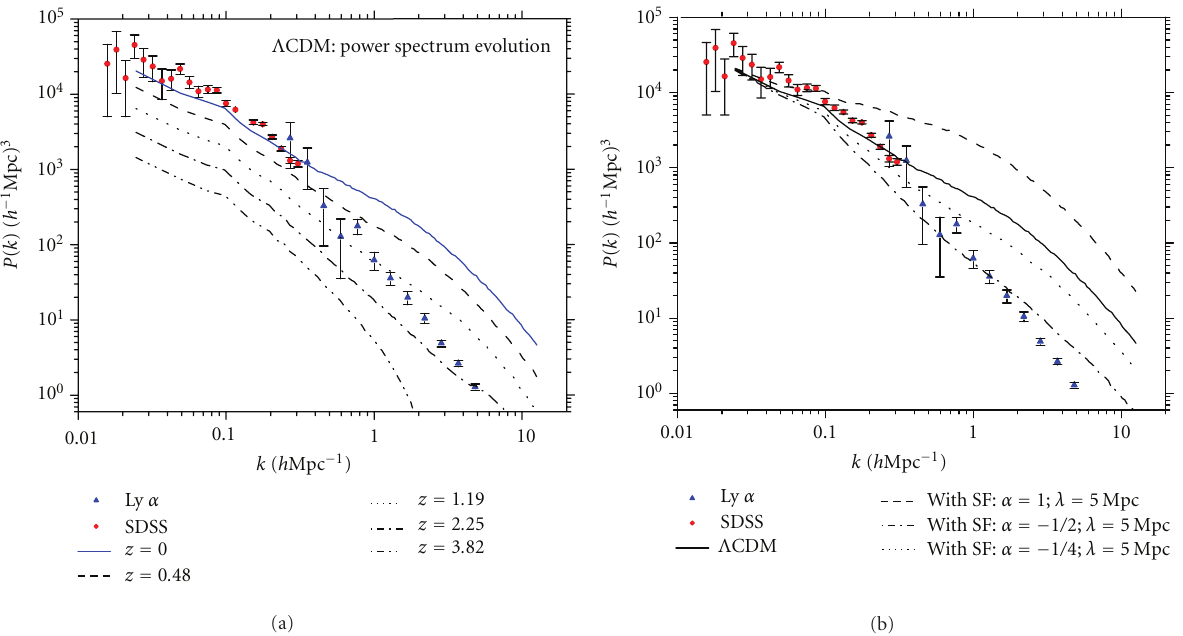
Figure 4: (a) Evolution of the power spectrum for the case which there is no SF. (b) The power spectrum including SF for several values of parameter α and with λ = 5Mp c/h . Experimental data are from galaxies in the Sloan Digital Sky Survey (SDSS) catalog and from an analysis of the Lyman- α forest